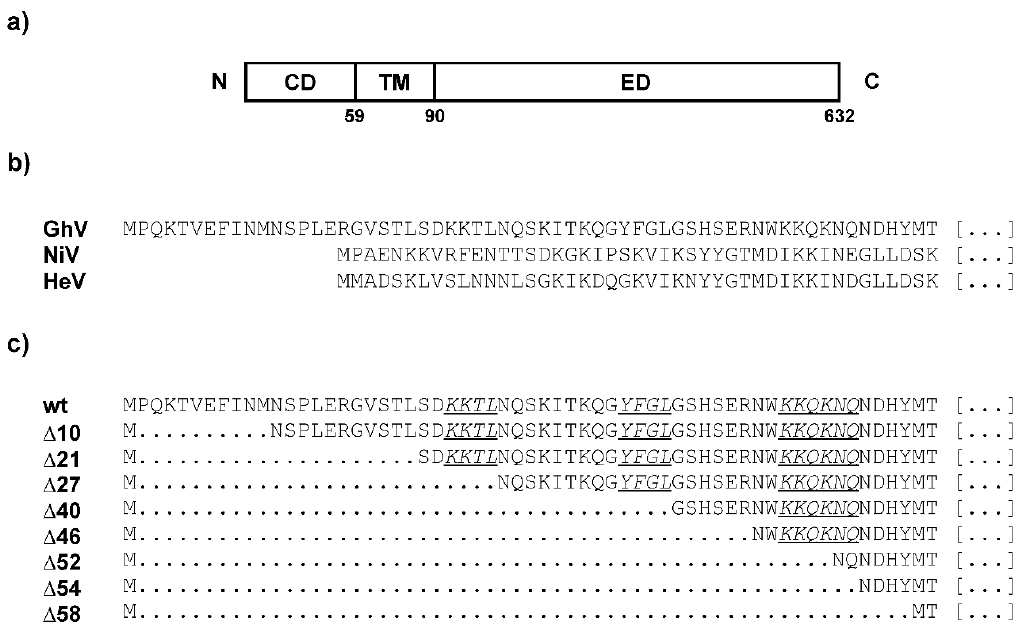
Figure 1. Organization of wildtype and truncated GhV G proteins. ( a ) Schematic illustration of the GhV G protein. CD: cytoplasmic domain, TM: transmembrane domain, ED: ectodomain. The TM was predicted using the online tool HMMTOP (www.enzim.hu/hmmtop/). ( b ) Amino acid sequence of the CD of NiV, HeV, and GhV G. ( c ) N-terminal amino acid sequences of GhV G wildtype (wt) and deletion mutants ( ∆ 10– ∆ 58). Potential lysine- and tyrosine-based retention motifs are underlined and written in italics.